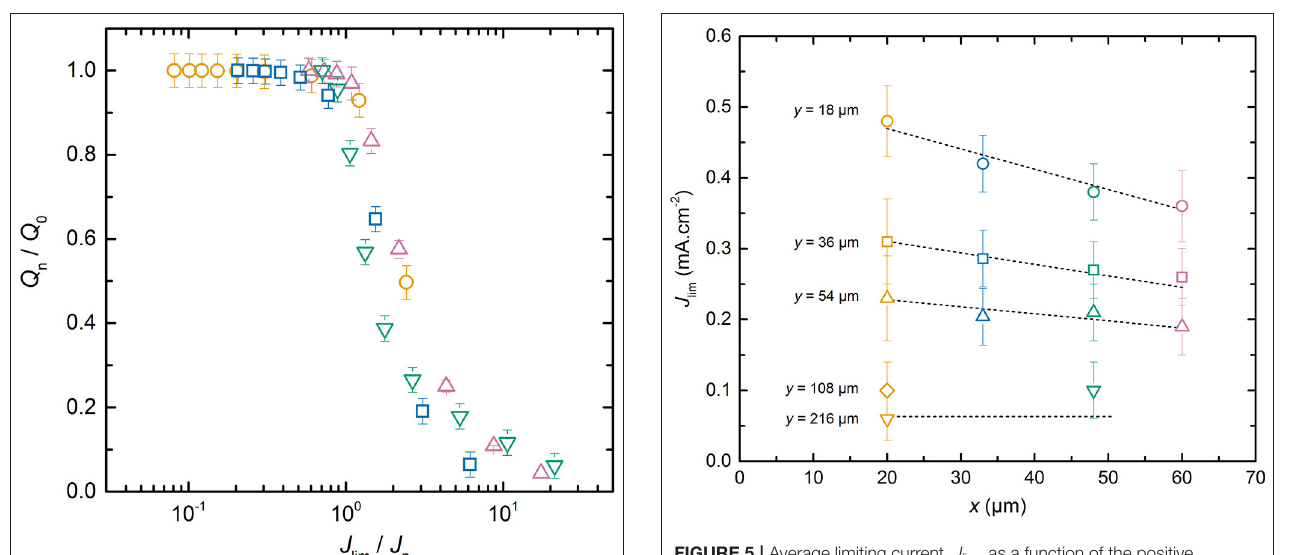
FIGURE 5 | Average limiting current, J lim , as a function of the positive electrode thickness, x . The dashed lines are guidelines for the eyes depending on the SPE thickness, y . The symbols correspond to SPE thickness y of ( (cid:13) ) 18, ( 2 ) 36, ( △ ) 54, ( ♦ ) 108, and ( ∇ ) 216 µ m. The symbol colors correspond to positive electrode thickness x of (orange) 20, (blue) 33, (green) 48, and (pink) 60 µ